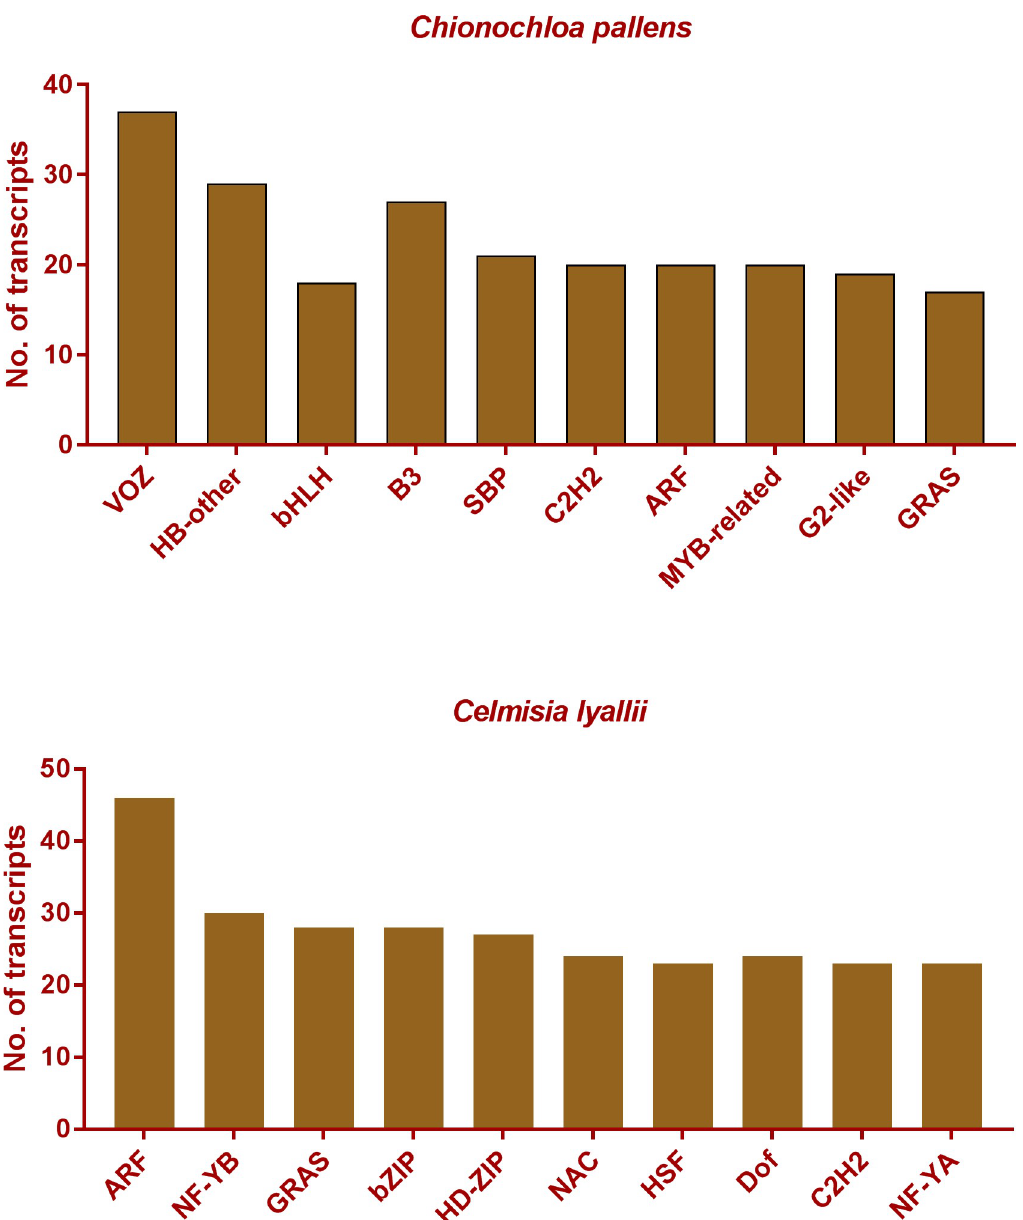
Fig 2. Identification of transcription factors from C . lyallii and C . pallens . A subset list of the number of transcription factors identified from the assembled transcriptome of C . lyallii and C . pallens .